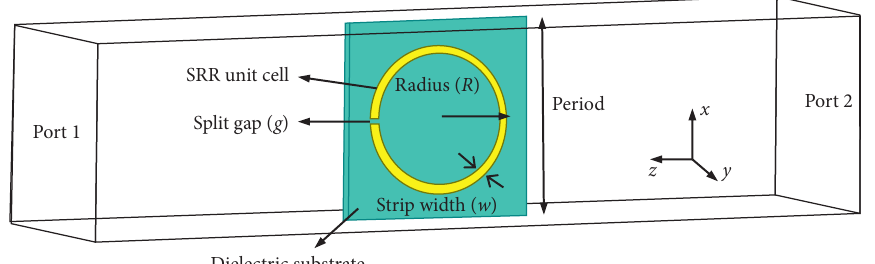
Figure 4: Waveguide structure used for characterization of the SRR unit cell ( E -field points the x -direction, H -field is in the y -direction, and the propagation is the z -direction).